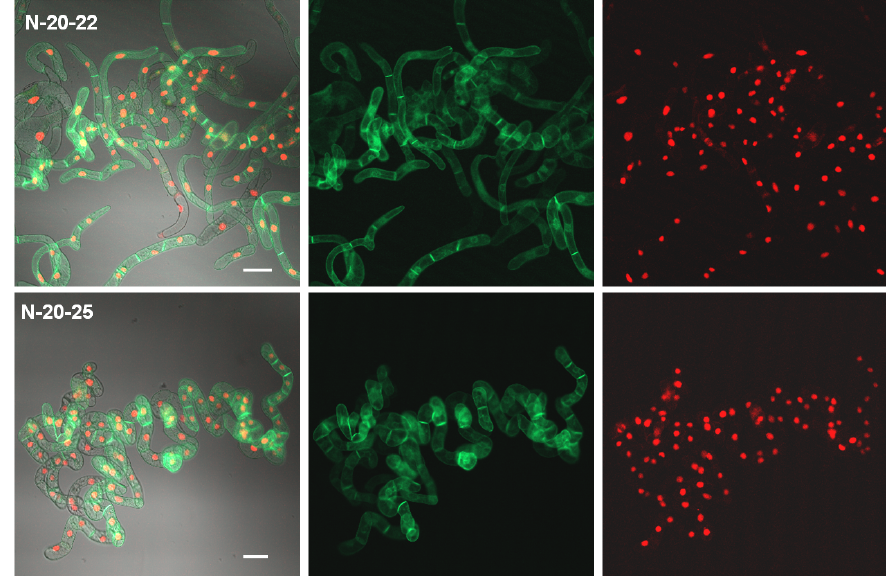
Figure 8. Two different clonal selections of the double-transformed cell line N-20. The most promising cell line N-20 was re-selected in order to obtain a performing cell line. The resulting cell lines (N20–22 and N20-25) are characterized by a high ratio of bright fluorescent cells (>95%). Images were taken as described in the legend to Figure 5. Cells were induced for 24 h with 10 µM Dex and 6 µM Est (final concentrations). White bars represent 50 µm.